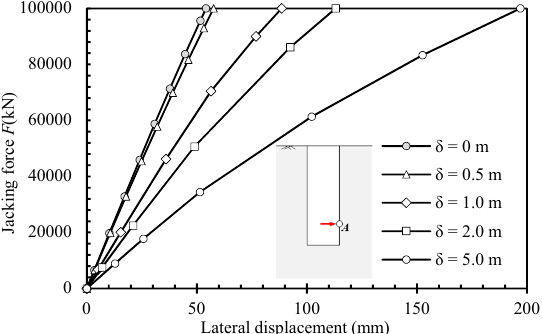
Figure 7. Load–lateral displacement curves at loading points under different thicknesses of the disturbance ring.